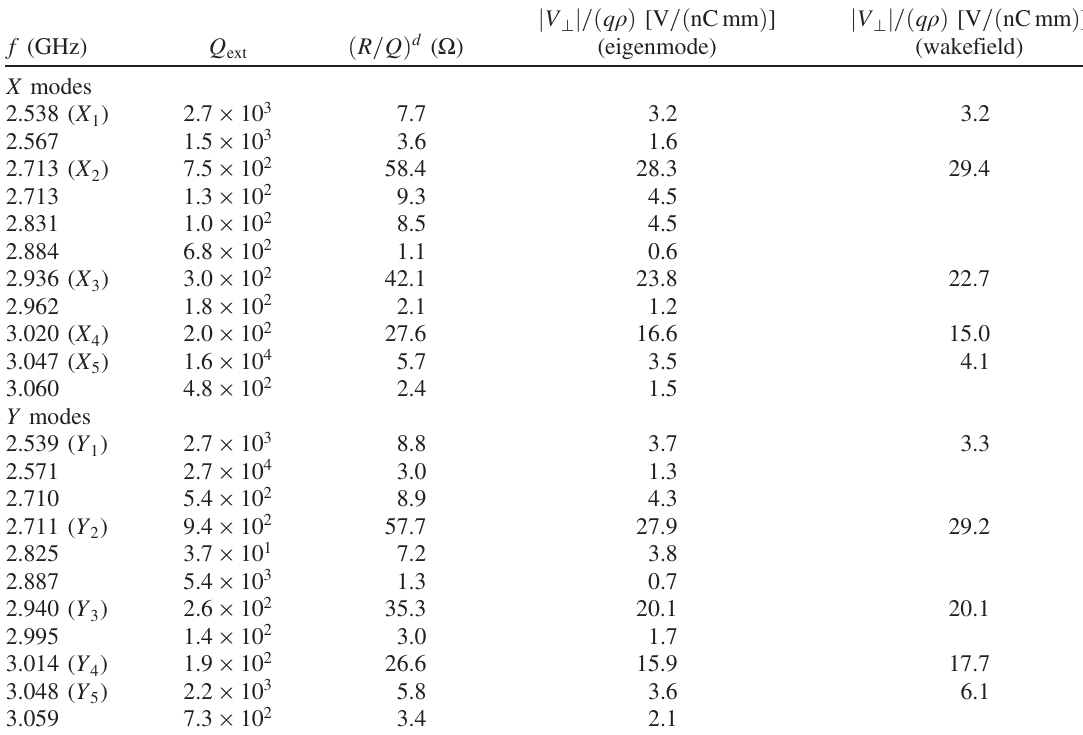
TABLE III. Simulation results for the dipole modes with ð R=Q Þ d > 1 Ω . f (GHz) Q